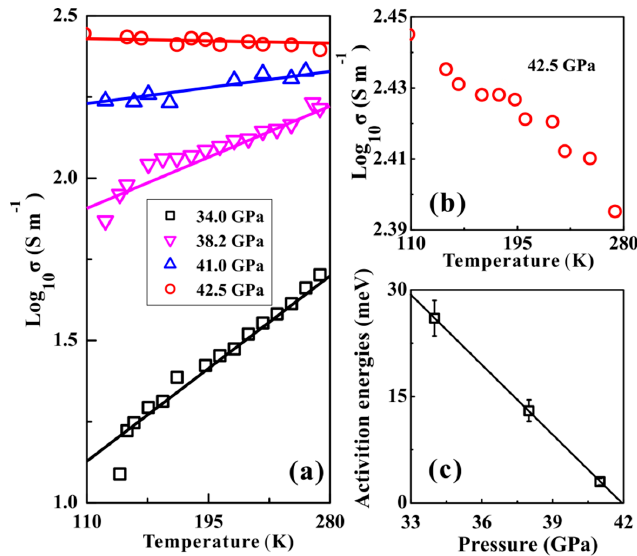
Figure 6. ( a ) The relationship between the temperature and electrical of orpiment at selected pressure. ( b ) Pressure dependence of activation energy for orpiment.